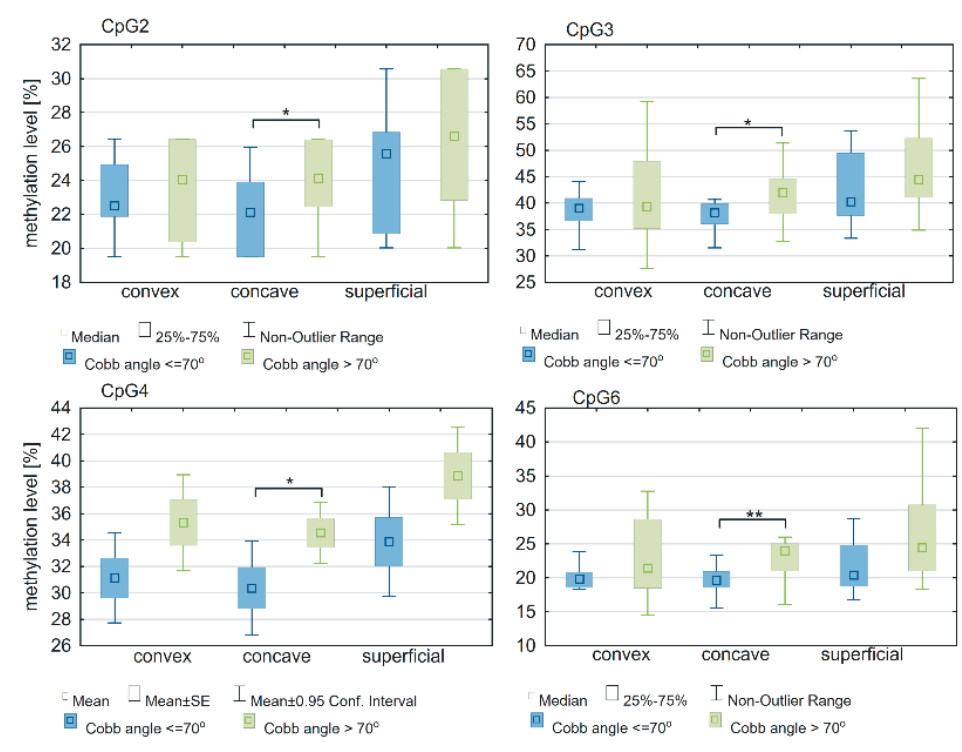
Figure 6. DNA methylation level within ESR1 T-DMR2 region in deep paravertebral muscles and superficial muscles in patients with Cobb angles ≤ 70° and >70°; * p < 0.05, ** p < 0.01.